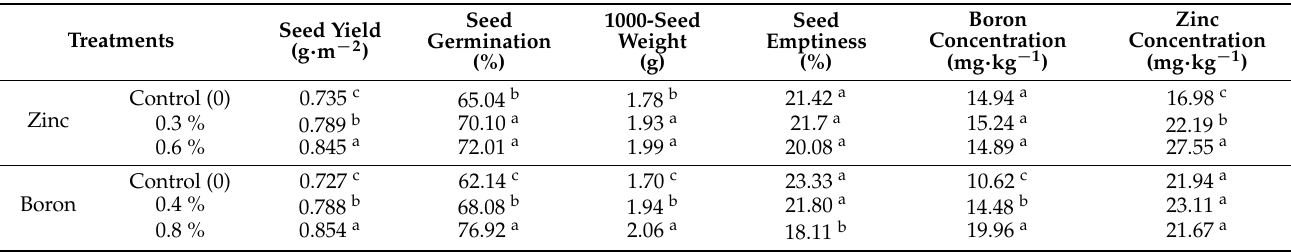
Table 5. Mean comparison of the simple effects of boron and zinc foliar application on seed traits and B and Zn contents of the leaf of S. khuzistanica in the second year of the experiment.